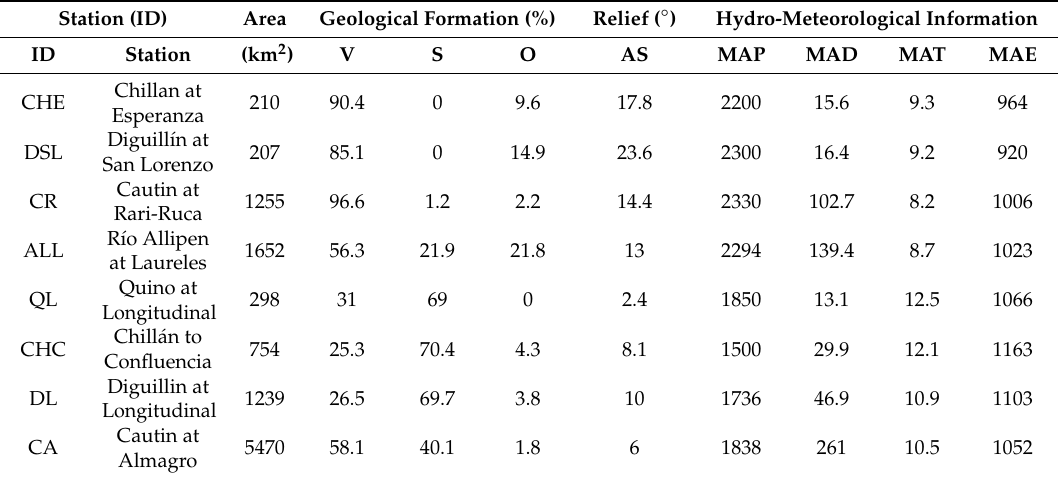
Table 1. Monitoring stations, availability, geological formation and hydro-meteorological information in study